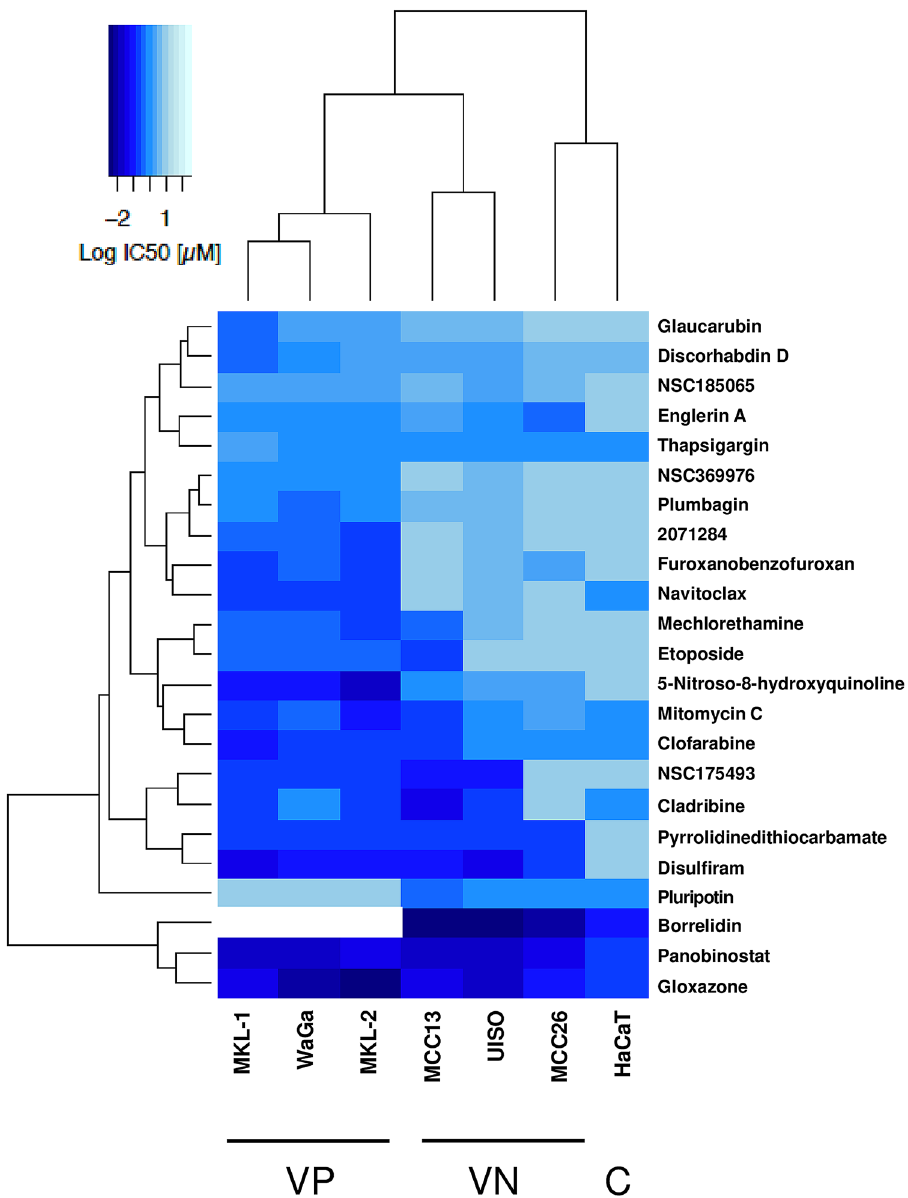
Figure 2. Visualization of drug effectiveness in MCC and control cell lines. VP-MCC, VN-MCC and HaCaT (control) cells were treated with 23 compounds for 72 h. CellTiter Glo assay was used to measure cell viability and determine the IC 50 for each compound. The log of the IC 50 was determined and visualized in a heatmap generated in R version 1.3.1073 (R Core Team (2013). R: A language and environment for statistical computing. R Foundation for Statistical Computing, Vienna, Austria. http:// www.R- proje ct. org/). Dendrograms indicate cell line and compound similarities based on unsupervised hierarchical clustering. Darker shades indicate higher potency. For borrelidin, IC 50 could not be calculated (white region) for VP-MCC lines (see Supplementary Figure S4 for dose–response curves for all compounds and cell